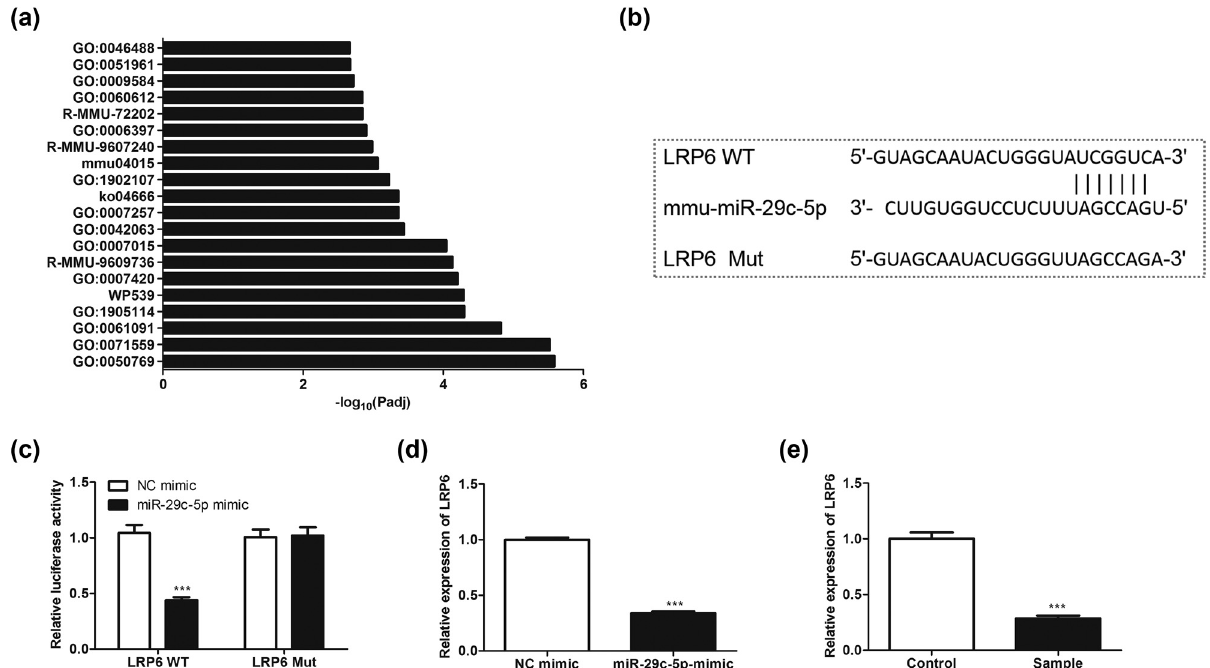
Figure 5: Veri fi cation of the interaction between miR - 29c - 5p and LRP6: ( a and b ) Bioinformatic databases, TargetScan and Metascape, were applied to predict the possible downstream regulatory targets of miR - 29c - 5p and screen out the targets that participated in regulating the Wnt pathway. ( c ) The binding of miR - 29c - 5p to LRP6 was proved by dual - luciferase reporter gene assay. ( d ) miR - 29c - 5p mimic or NC - mimic was transfected into astrocytes. QRT - PCR was carried out to quantify the LRP6 expression. ( e ) A total of 20 patients with ischemic stroke and 20 matched healthy controls were included, and the blood samples were isolated fromthem. The expression ofLRP6 was analyzed by qRT - PCR. Data are presented as an average of three independent assays. *** P < 0.001 vs NC